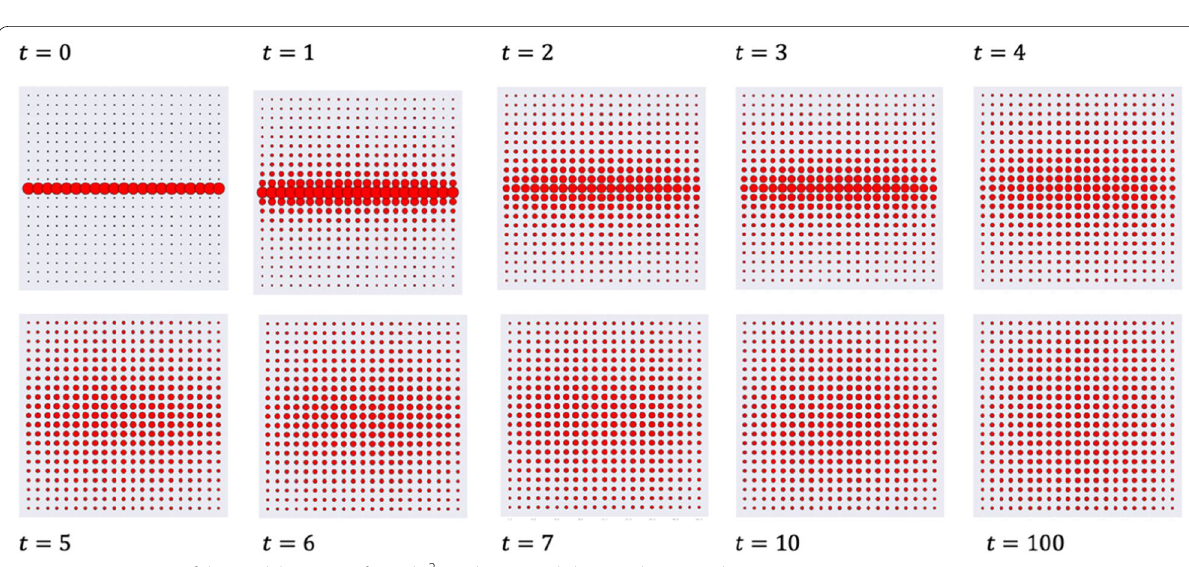
Fig. 9 Convergence of the Model Function f rs ∝ d − 2 rs Used to Spread The Population on the